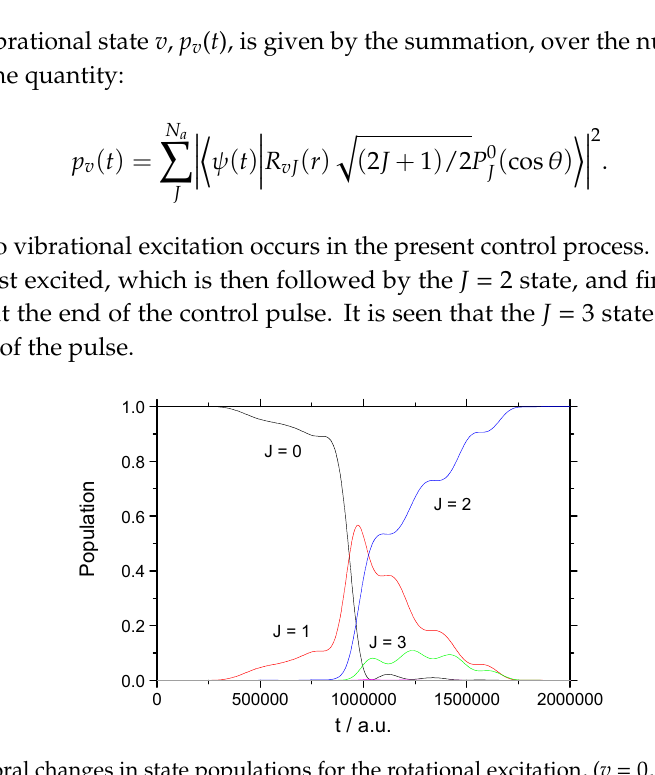
Table 3. Comparison of the yields with the full ( ˆ H 0 + ˆ H 1 + ˆ H 2 ) and partial Hamiltonians ( ˆ H 0 + ˆ H 1 and + ˆ H ˆ H 0 2 ), obtained using the optimal fields for the full Hamiltonian. Init.